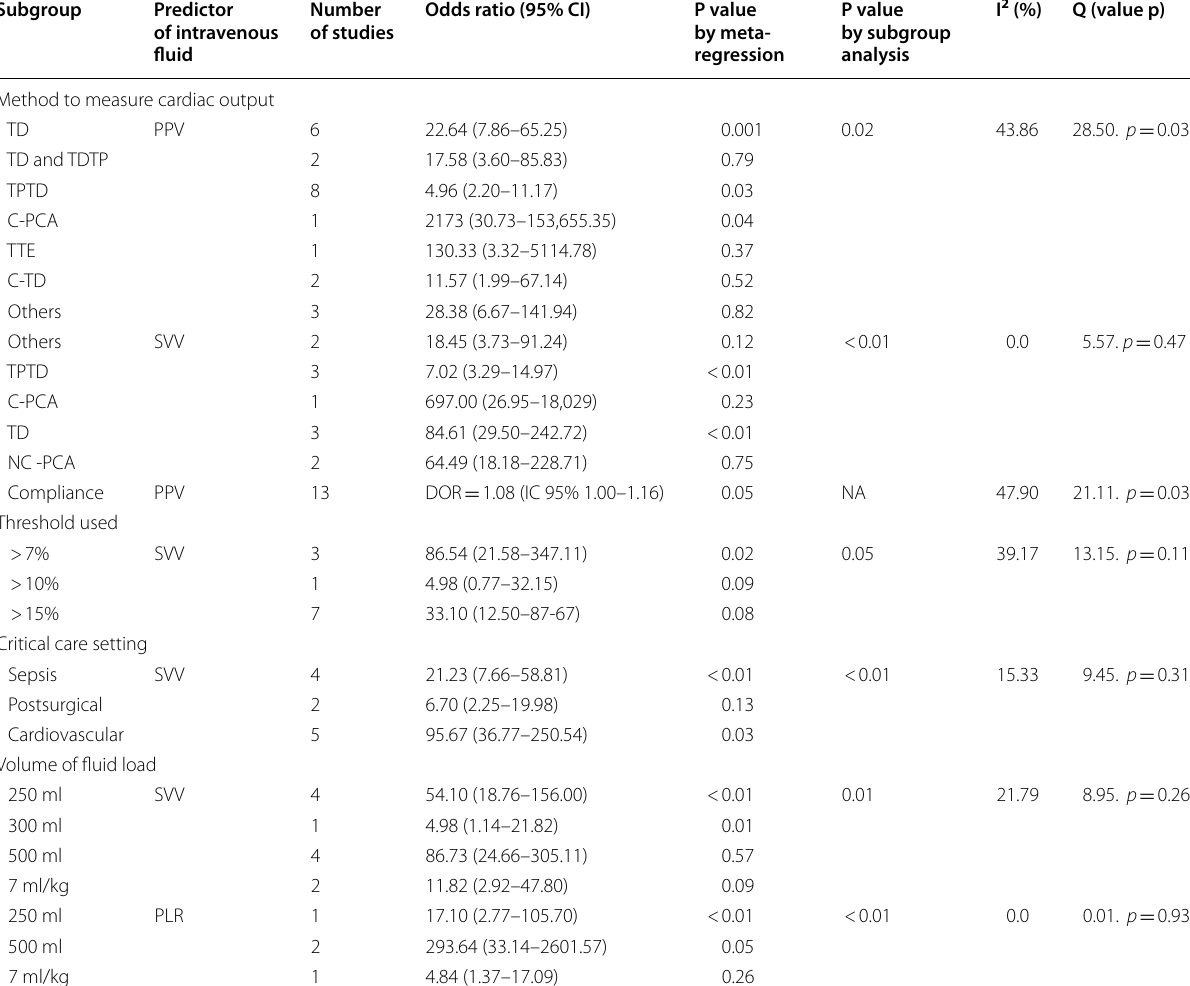
Table 4 Subgroups and meta-regression analysis